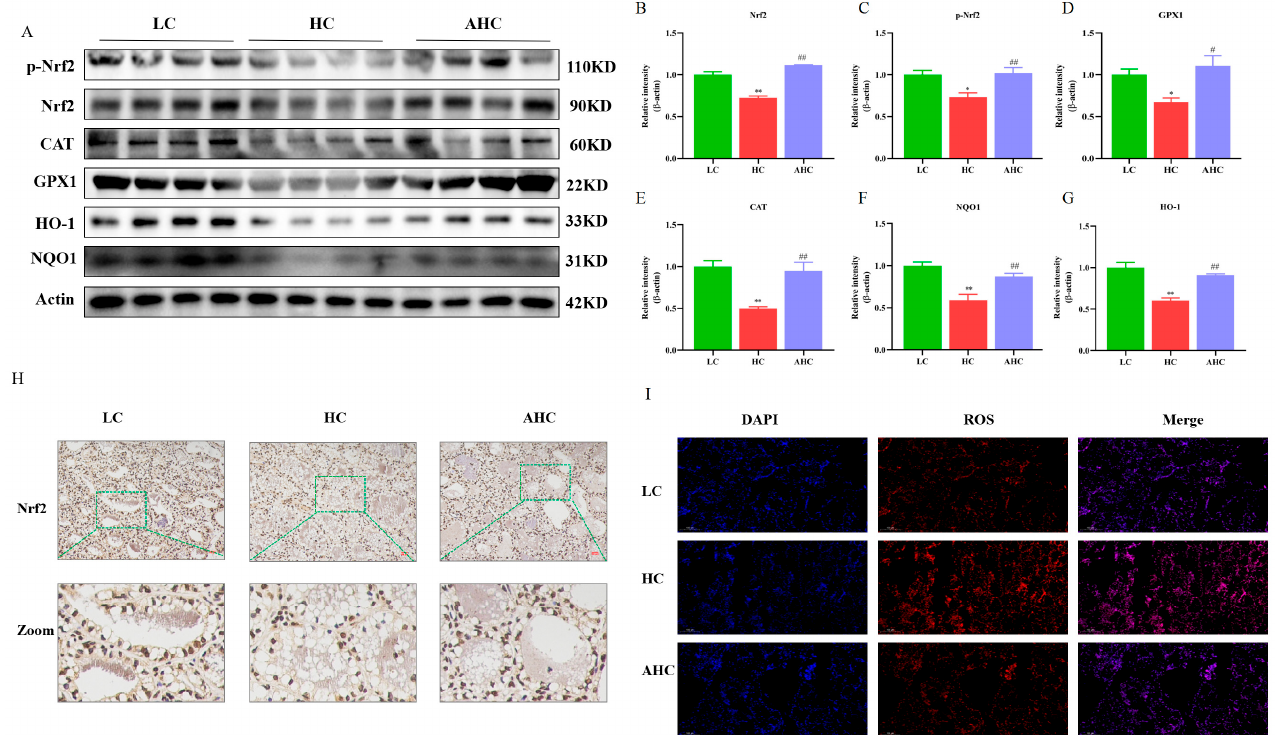
Figure 7. Disodium fumarate relieved the oxidative stress of mammary gland tissue induced by the high-concentrate diet. The protein expression of oxidative stress-related proteins ( A – G ). Data are presented as the relative protein abundances relative to actin (means ± SEM), * p < 0.05, ** p < 0.01 represent significant differences compared with LC diet. # p < 0.05, ## p < 0.01 represent significant differences compared with HC diet; immunofluorescence results of Nrf2, the red bar = 100 μ m ( H ). The green line represents zooming in on the selected area of the image. The fluorescence of ROS in the mammary tissue of Hu sheep. The bar = 100 μ m ( I ).